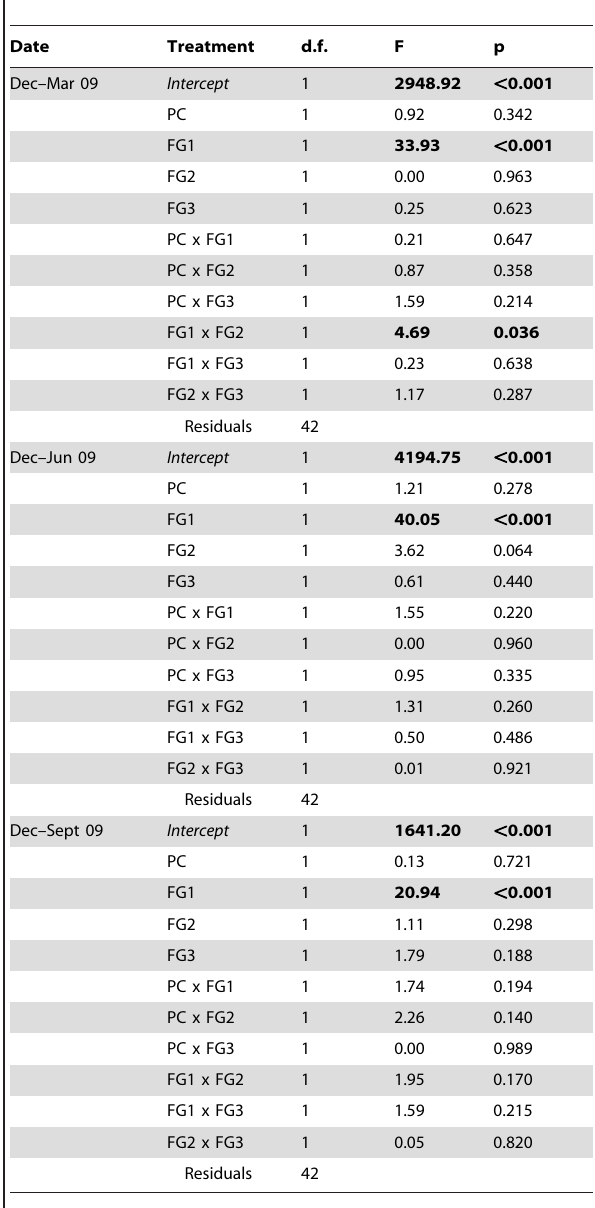
Table 4. Summary of treatment effects upon decomposition from mixed effects